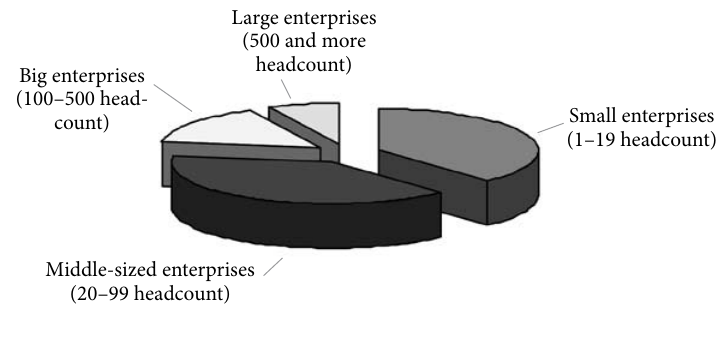
fig. 7. Structure of respondents by